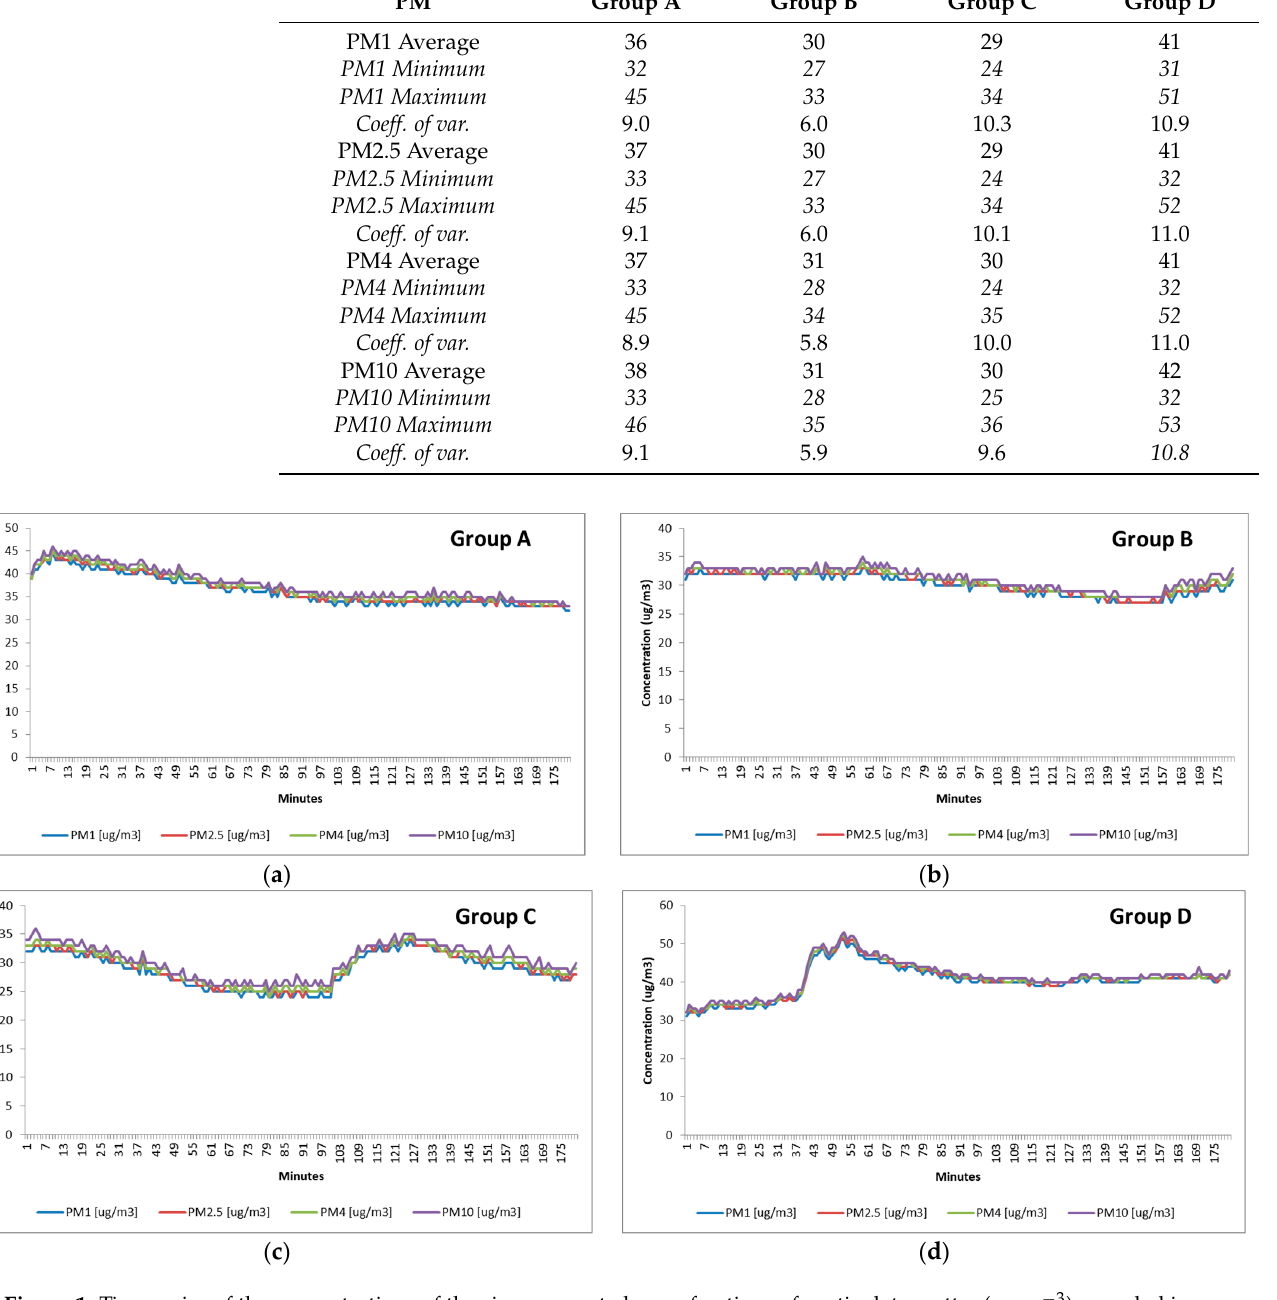
20.4 The mass balance approach provided approximations of the PM2.5 indoor concen- tration based on outdoor levels and other factors. Table 4 presents a comparison between modeled concentrations and the averaged values resulting from monitoring. While for